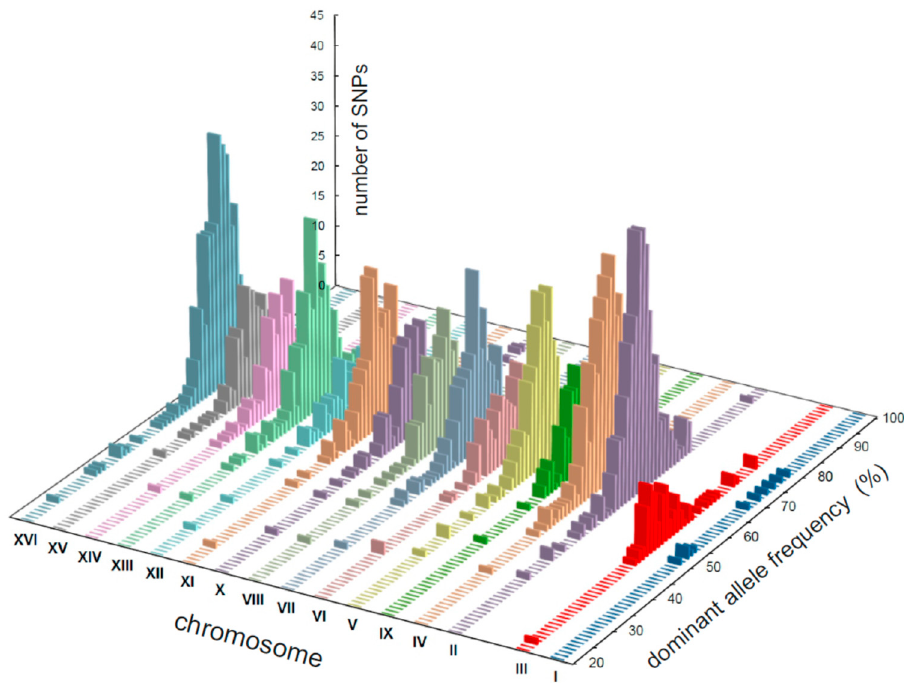
Figure 2. Frequencies of the dominant alleles at the SNP sites in the chromosomes.